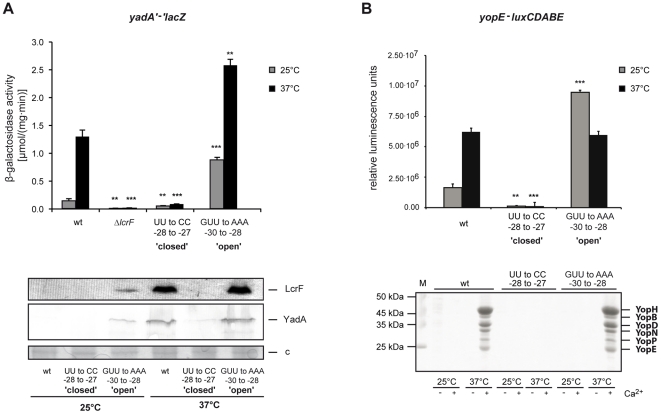

lcrF thermosensor-dependent expression of the yadA and yopE genes.(A) Strains YPIII (wildtype), YP66 (ΔlcrF) and the repressed and derepressed yscW-lcrF variants YP90 (UU-28/-27CC) and YP95 (GUU-30/-28AAA) harboring the yadA-lacZ fusion plasmid pSF1 were grown in LB medium at 25°C or 37°C. β-Galactosidase activity from overnight cultures was determined and is given in µmol min−1 mg−1 for comparison. The data represent the average ± SD from at least three different experiments each done in duplicate. Data were analyzed by the Student's t test. Stars indicate the results that differed significantly from those of the wildtype at the same temperature with ** (P<0.01), and *** (P<0.001). Whole-cell extracts from overnight cultures of Y. pseudotuberculosis YPIII (wildtype) and the repressed and derepressed yscW-lcrF variants YP90 (UU-28/-27CC) and YP95 (GUU-30/-28AAA) grown at 25°C or 37°C were prepared, and analysed by Western blotting with a polyclonal antibody directed against LcrF and YadA. A higher molecular weight protein (c) was used as control the protein content of the cell extracts. (B) Strains YPIII (wildtype) and the repressed and derepressed yscW-lcrF variants YP90 (UU-28/-27CC) and YP95 (GUU-30/-28AAA) harboring the yopE-luxCDABE plasmid pWO34 were grown in LB medium at 25°C and 37°C. Bioluminescence emitted by the cultures was monitored and is given as relative luminescence units (RLU) and represents the mean of three independent experiments done in triplicate. Data were analyzed by the Student's t test. Stars indicate the results that differed significantly from those of the wildtype at the same temperature with ** (P<0.01), and *** (P<0.001). The panel below shows TCA-precipitated supernatants of YPIII (wildtype), the repressed and derepressed yscW-lcrF variants YP90 (UU-28/-27CC) and YP95 (GUU-30/-28AAA) grown at 25°C and 37°C in the presence (+) or absence (−) of Ca2+. The secreted Yop proteins are indicated.